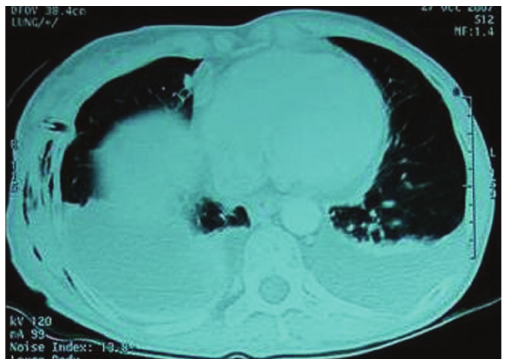
Figure 2: Case 1: CT scan revealing extensive bilateral pleural e ff usion.